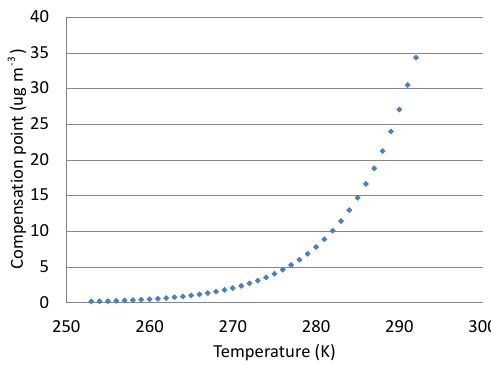
Figure 1. Compensation point ( C g ) relationship to temperature; C g for evergreen needleleaf LUC shown as